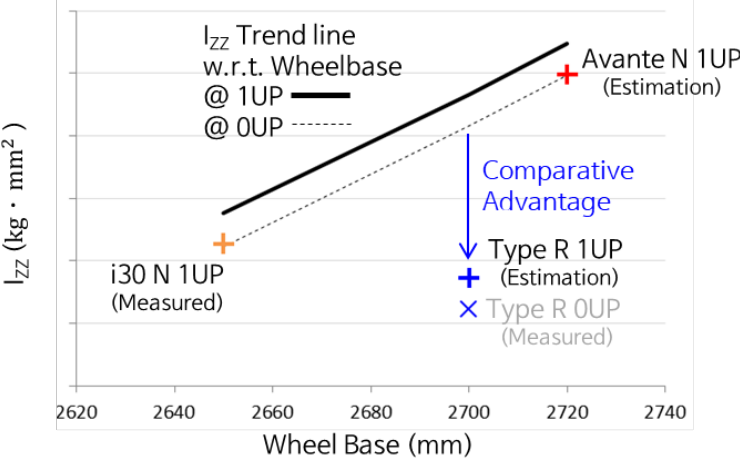
Figure 7. Izz (moment of inertia about the z-axis) Estimation: Trend Model + Measured Data.